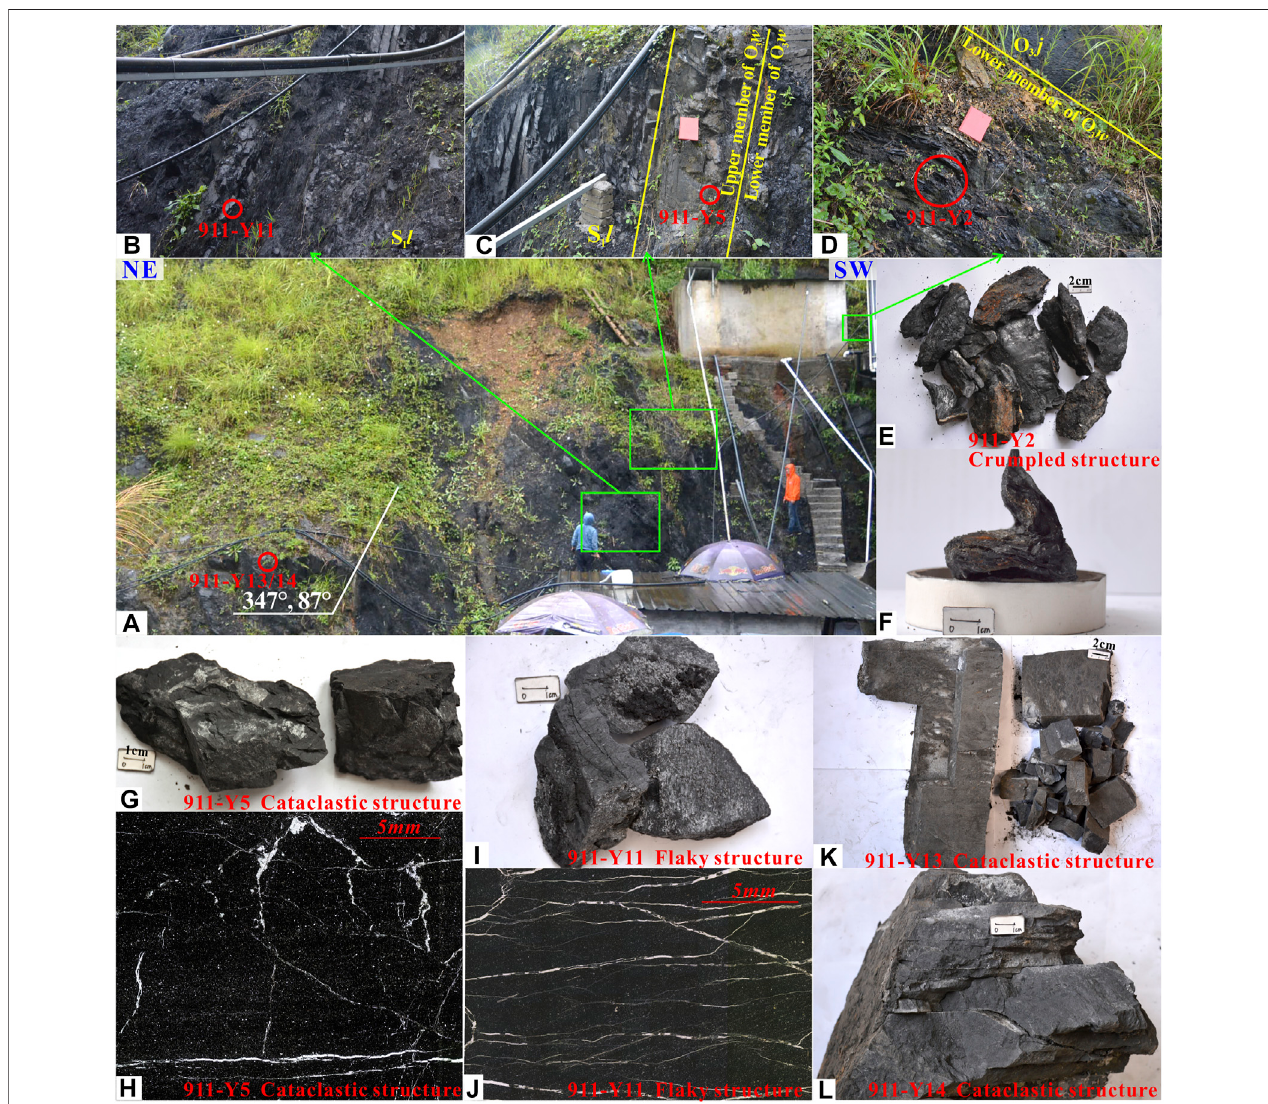
FIGURE6| Variations inshale deformation ofdifferentsegmentation oftheWufeng – Longmaxi Formation (observationpoint G1101). Notes: (A) apanoramaofthe Wufeng (O 3 w ) and Longmaxi (S 1 l ) Formation; (B) the Lower member of the S 1 l Formation; (C,D) the Upper and Lower member of the O 3 w Formation; (E-L) macro and micro deformation features of shale samples with collection locations marked in A-D.